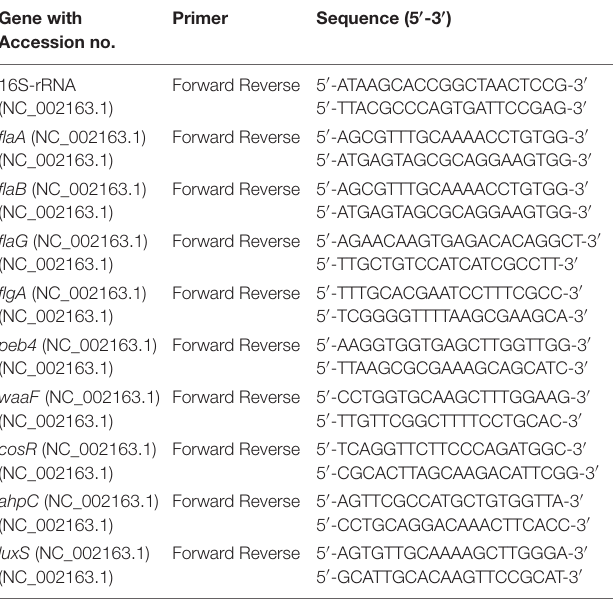
TABLE 1 | Primers used for gene expression analysis using real-time quantitative PCR. Gene with Primer Sequence (5 (cid:48) -3 (cid:48) ) Accession no. 16S-rRNA